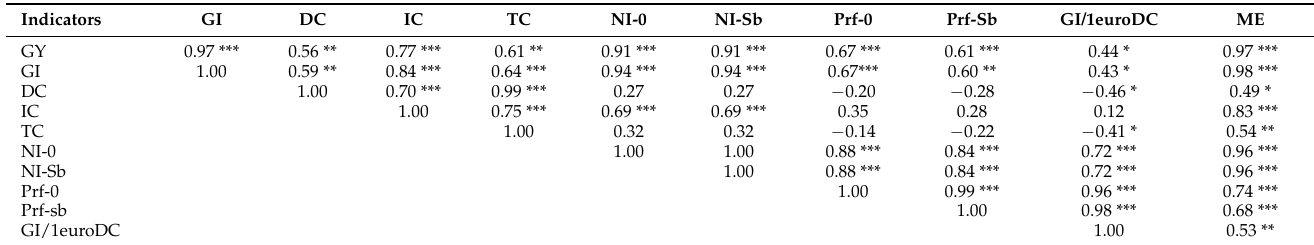
Table A3. Correlation matrix of basic economic indices of winter wheat and grain yield, simulation for 2022, n =